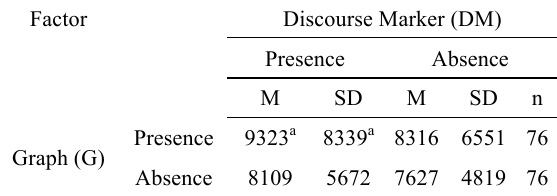
Table 2. Mean and Standard Deviation for Fixation Time on the cause segment